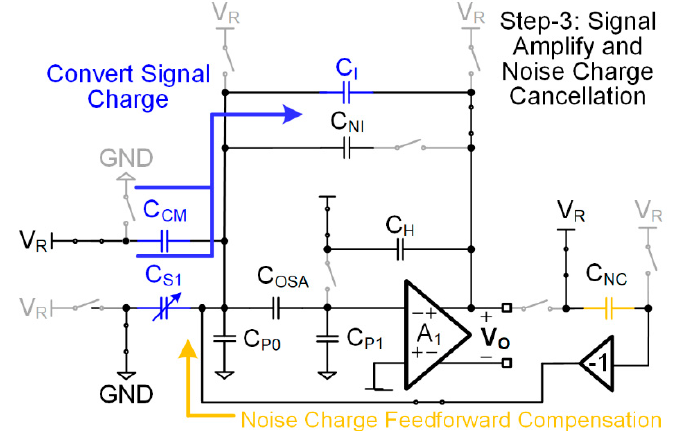
Figure 7. The noise fake integration of the reset noise sampling feedforward technique.